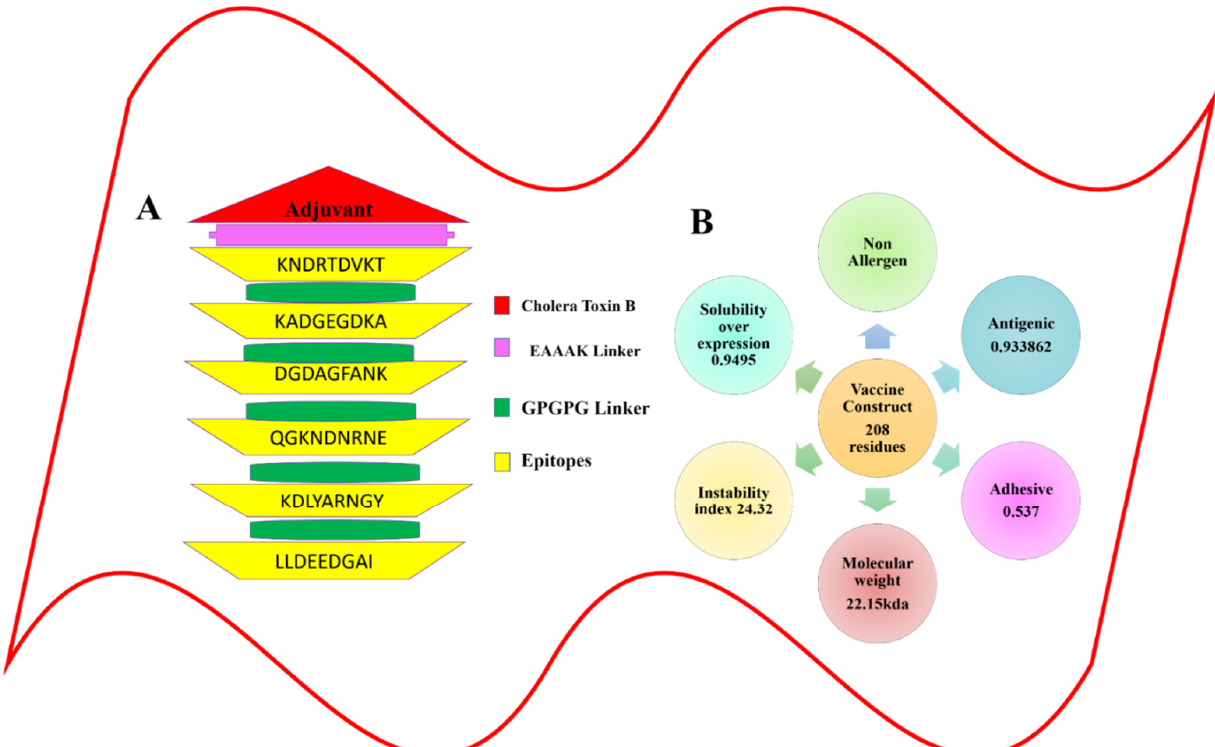
Figure 3. Graphical representation for the multi-epitope-based peptide vaccine construct. ( A ) Schematic diagram of the multi-epitope-based peptide vaccine construct. ( B ) The physiochemical properties calculated for the multi-epitope-based peptide vaccine construct.